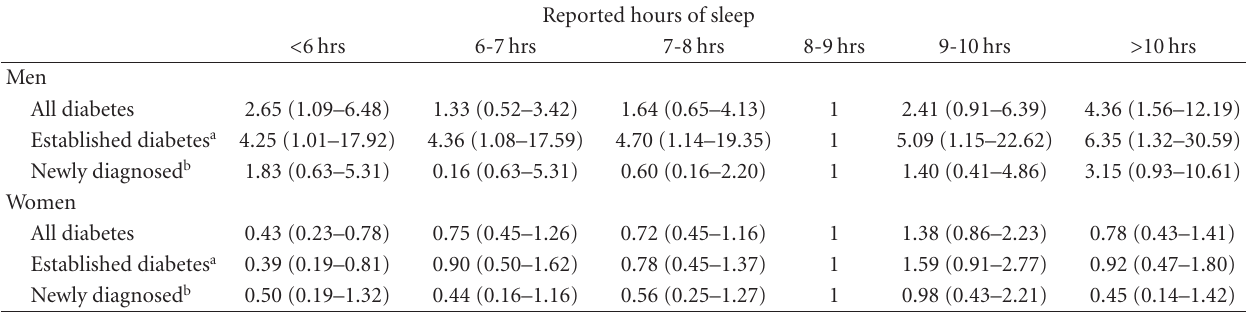
Table 4: Odds ratios (95%CI) for the e ff ect of reported hours of sleep on risk of diabetes by sex in Jamaican adults. All models adjusted for age, BMI, and family history of